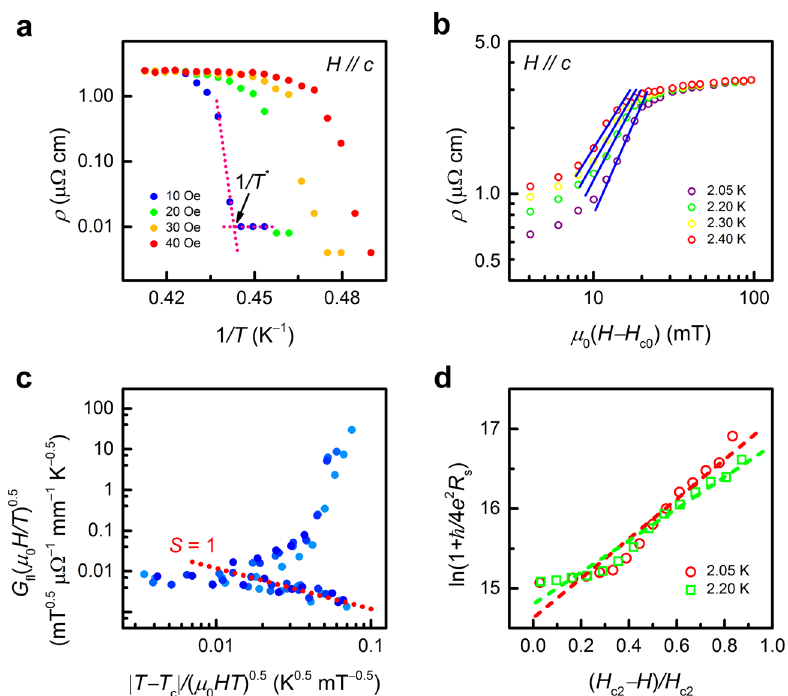
Fig. 8 Characteristics of Bose-metal phase in AuSn 4 . a Details of some selected low- fi eld Arrhenius plots of resistivity with H // c -axis, where dashed lines illustrate the resistivity deviation from the thermally activated behavior to a small value at temperature T *, as compared to the normal-state resistivity. b A log – log scale plot of resistivity vs. perpendicular magnetic fi eld μ 0 ( H − H c0 ) for temperatures below T BKT . Solid lines represent the fi t to the power-law dependence, as described in the text. c Ullah – Dorsey scaling of fl uctuation conductivity using the ρ ( T ) data in the presence of a magnetic fi eld. The dashed (cid:5) (cid:6) (cid:1) h (cid:2) H c 2 ; c (cid:2) H line indicates the slope of − 1 in a log – log plot. d Plots of the ln 1 þ 1 R H c 2 ; c relation at temperatures of 2.05 and 2.20 K, where the dashed lines 4 e 2 s represent the linear fi t to Eq. (4) with an extra constant C 0 , where C 0 = 14.63 and 14.80 for 2.05 and 2.20 K, respectively.